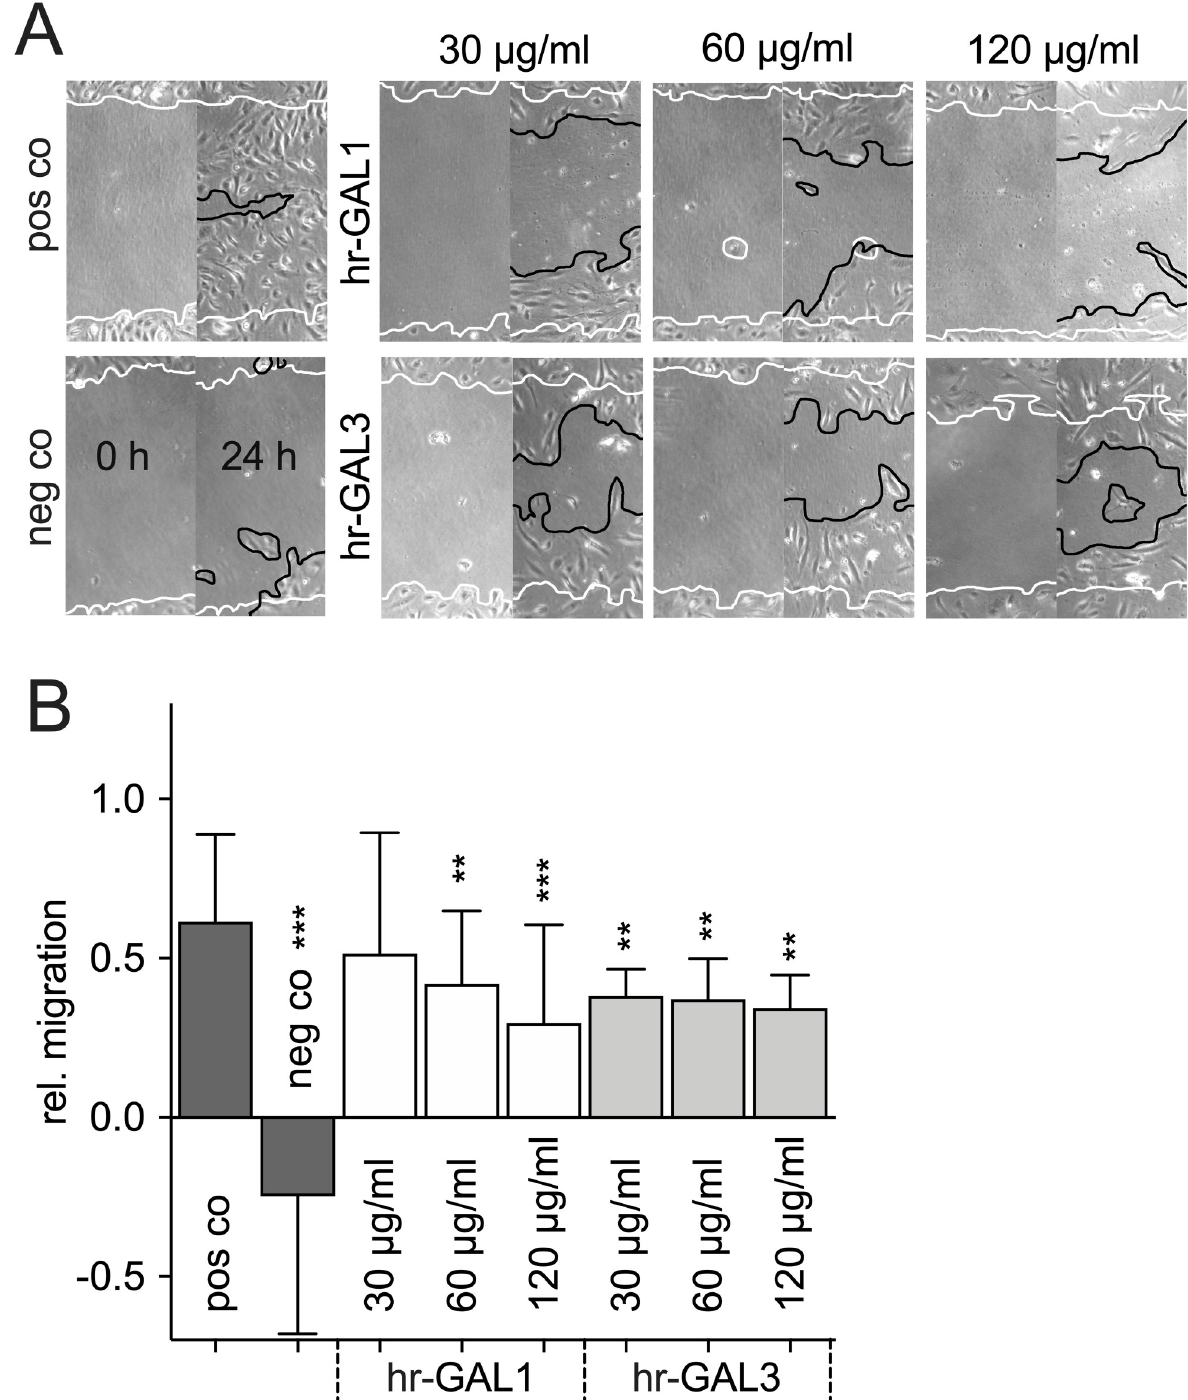
Fig 4. hr-GAL1 and 3 inhibit migration of HRMEC in vitro . Scratch migration assay (A) and quantification (B) of HRMEC after incubation with 30, 60 and 120 μ g/ml hr-GAL1 or 3 for 24 h. The left half of all images shows the wounded area immediately after scratching (0 h), the right half the same region after incubation for 24 h. � positive control (pos co) vs treated cells or negative control (neg co), ��� p < 0.001; n = 20 of 4 independent experiments.